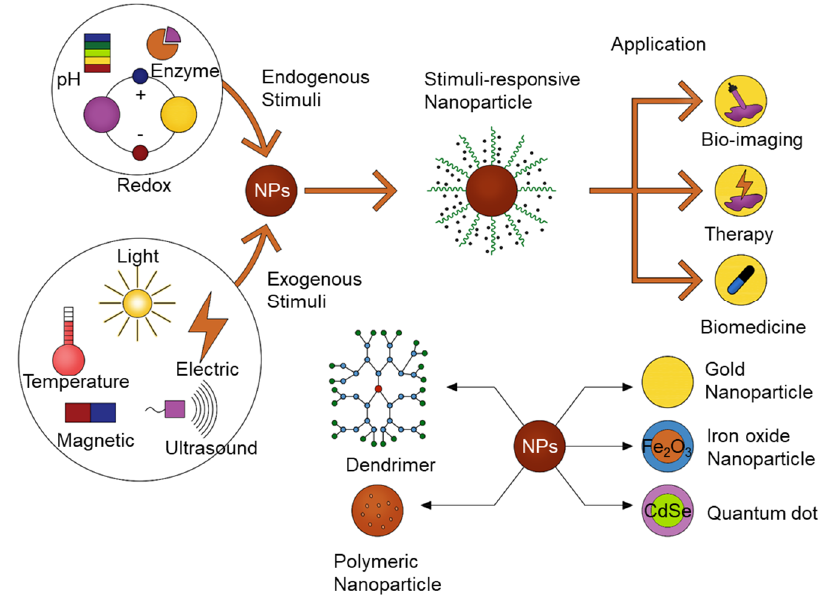
Figure 1. Schematic diagram of stimuli-responsive nanomaterials used for bioimaging, therapy, and triggered drug release.